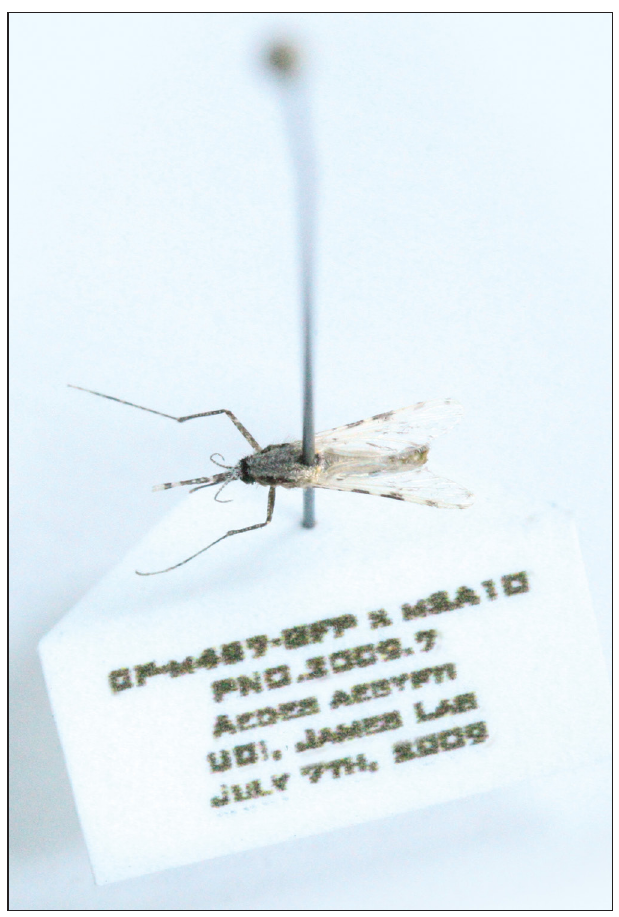
Figure 4: Transgenic mosquito (Aedes agypti), pinned specimen, 2009. photos by the Center for PostNatural History